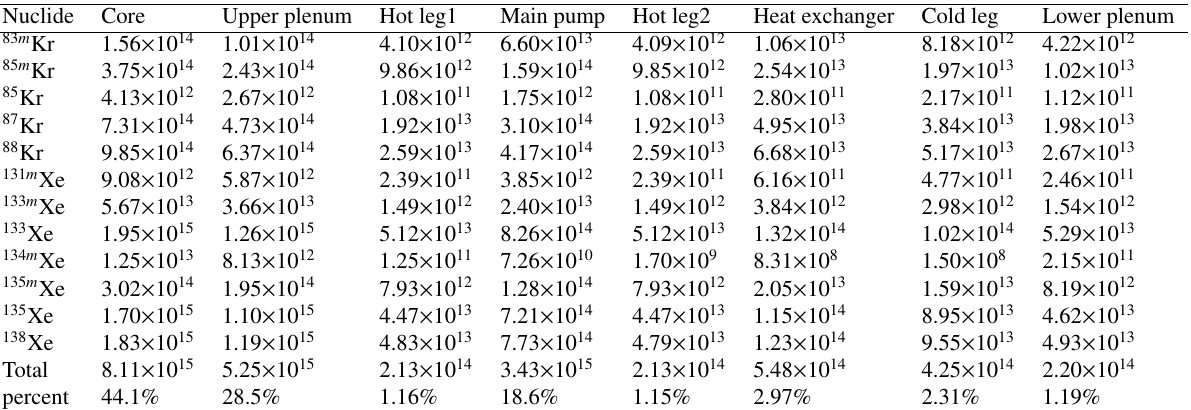
Table 3. Activity distribution of krypton, xenon and iodine in the primary Loop at the EOL Nuclide